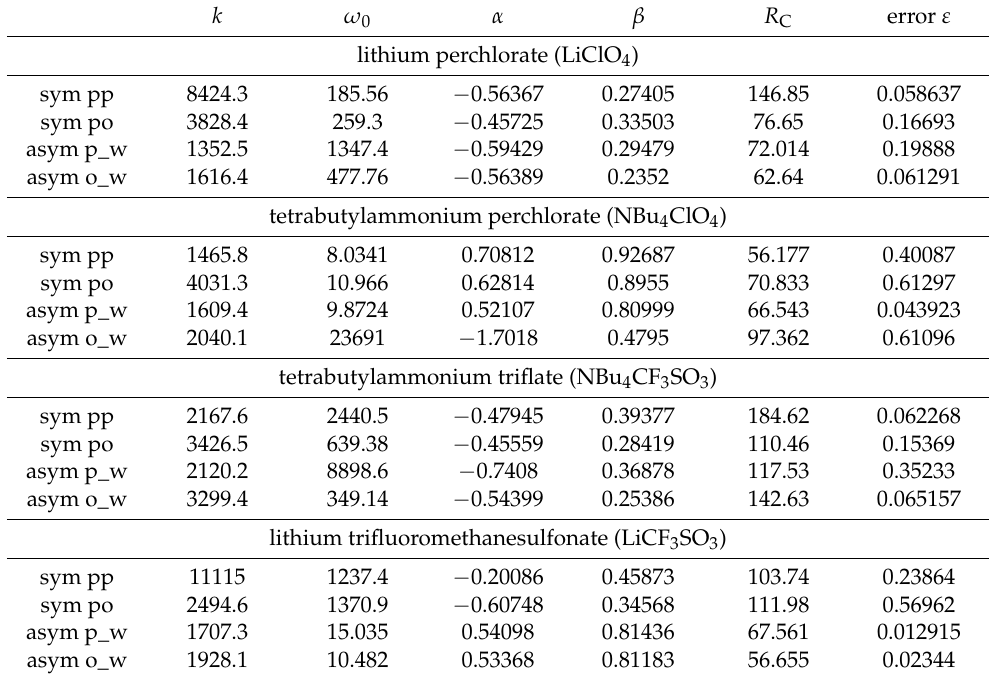
Table 2. Results of the estimation of the parameters of the model based on poles and zeros of the fractional-order